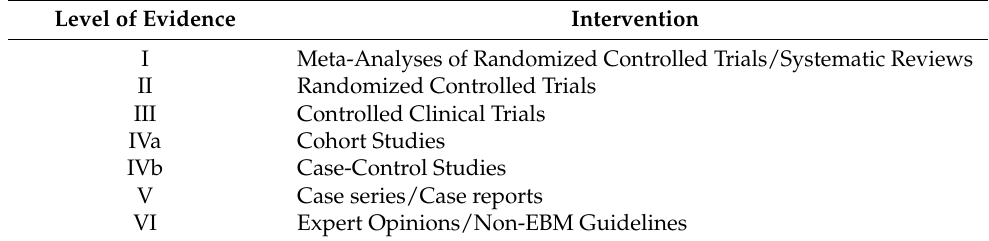
Table 1. Classification standard of the evidence level.